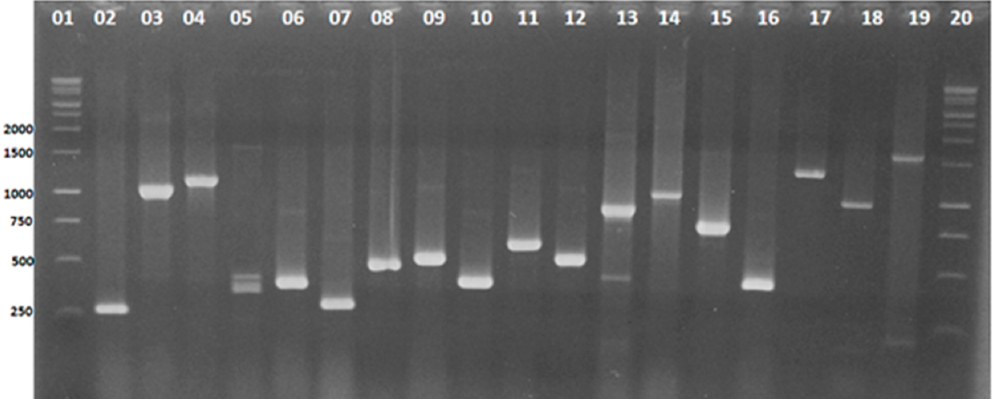
Figure 1. Electrophoretic profiles of the virulence genes investigated in the 99 isolates of Pseudomonas aeruginosa: 1.5% agarose gel stained with ethidium bromide. Lines 1 and 20: 1 Kb DNA ladder (Promega, USA). Lines 2 to 19 profiles of the isolates carrying the genes: oprI (249 bp), exoY (1035 bp), exoT (1.159 bp), lasB (284 bp), toxA (396 bp), algD (300 bp), plcN (481 bp), oprL (504 bp), phzl (392 bp), plcH (608 bp), exoS (504 bp), phzM (875 bp), apr (1.017 bp), Prot IV (752 bp), pilB (408 bp), nan-1 (1.316 bp), aprA (993 bp), and pilA (1.675 bp).